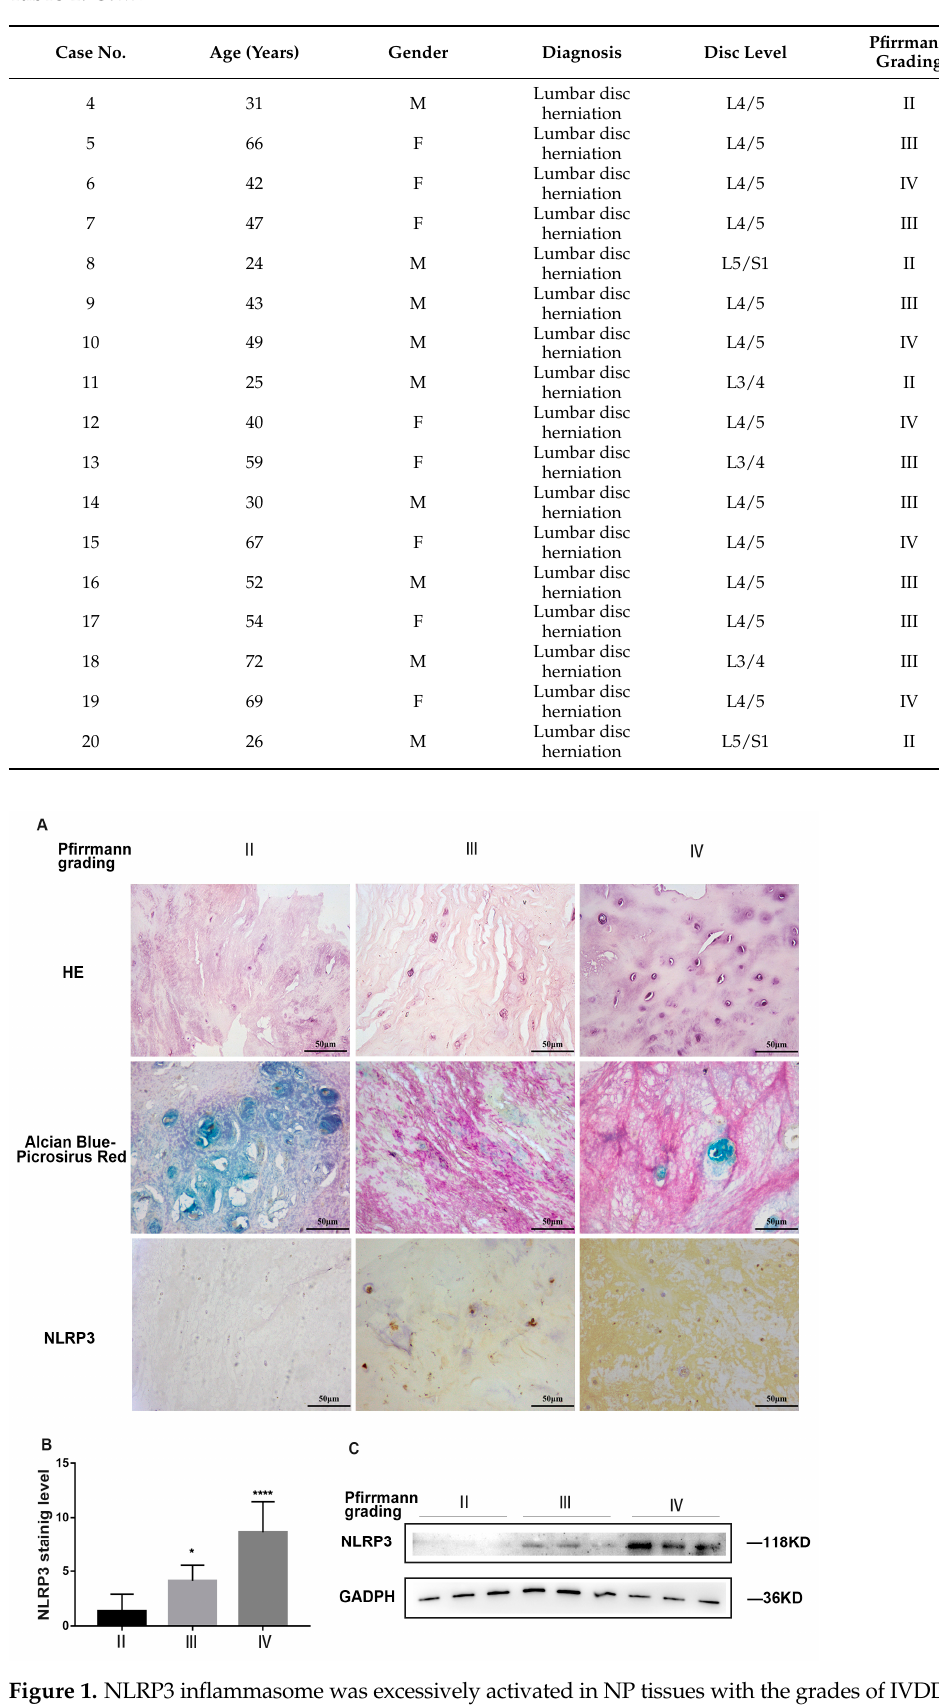
Figure 1. NLRP3 inflammasome was excessively activated in NP tissues with the grades of IVDD ( A Figure 1. NLRP3 in fl ammasome was excessively activated in NP tissues with the grades of IVDD ( A ). HE, Alcian blue/Picrosirius red staining, and IHC staining of NLRP3 in di ff erent degenerative NP tissues ( Ⅱ – Ⅳ groups according to P fi rrmann grade), n = 3. ( B ). Statistical analysis of NLRP3 immunohistochemistry of NP tissues with di ff erent degeneration grades. ( C ). Western blot of NLRP3 protein in di ff erent degenerative NP tissues. The data are shown as the means ± SD, n = 3. *, compared to Ⅱ group; * p < 0.05, **** p < 0.0001. Table 1. Summary of patients’ information. Case No.